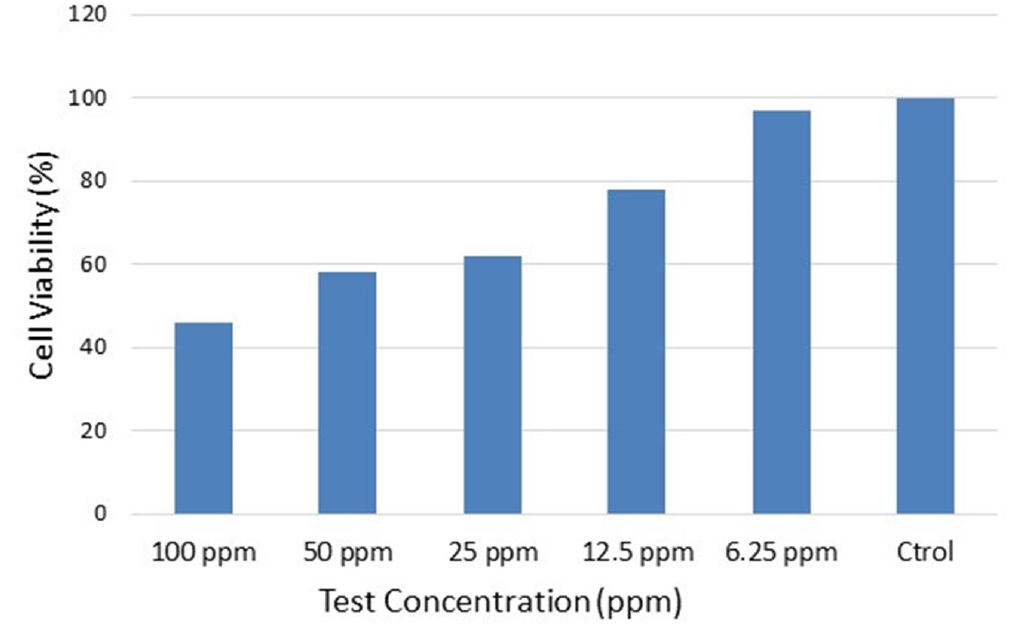
Figure 12. Effect of graphene on the generation of cytotoxic effects in the colon adenocarcinoma cell line.